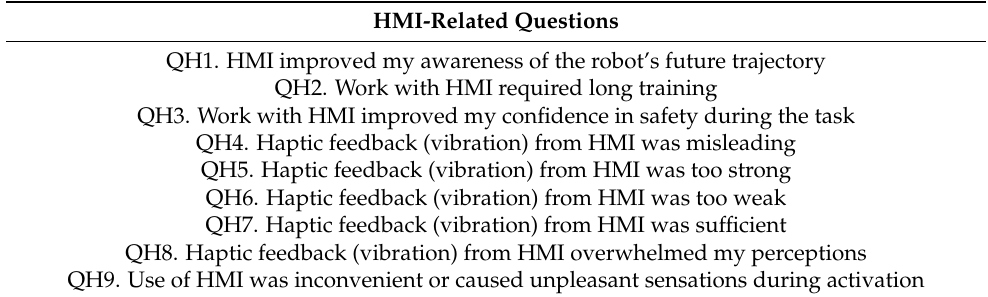
Table 3. HMI-related